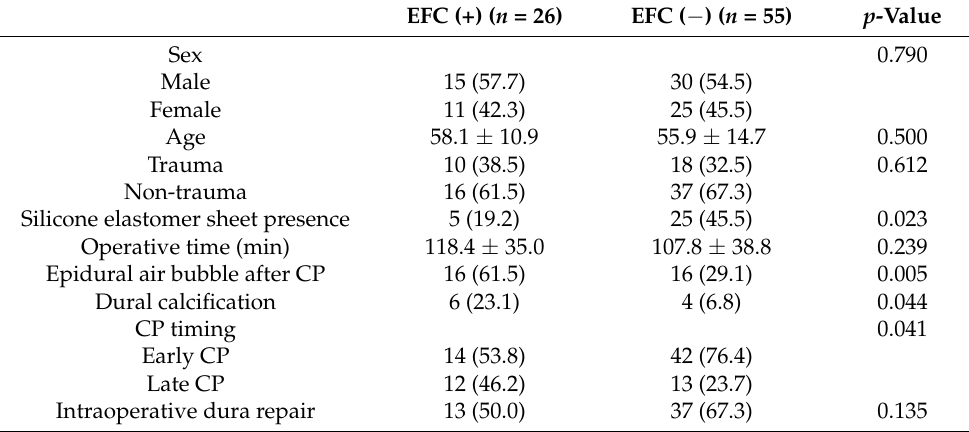
Table 4. Result of epidural fluid collection after cranioplasty.